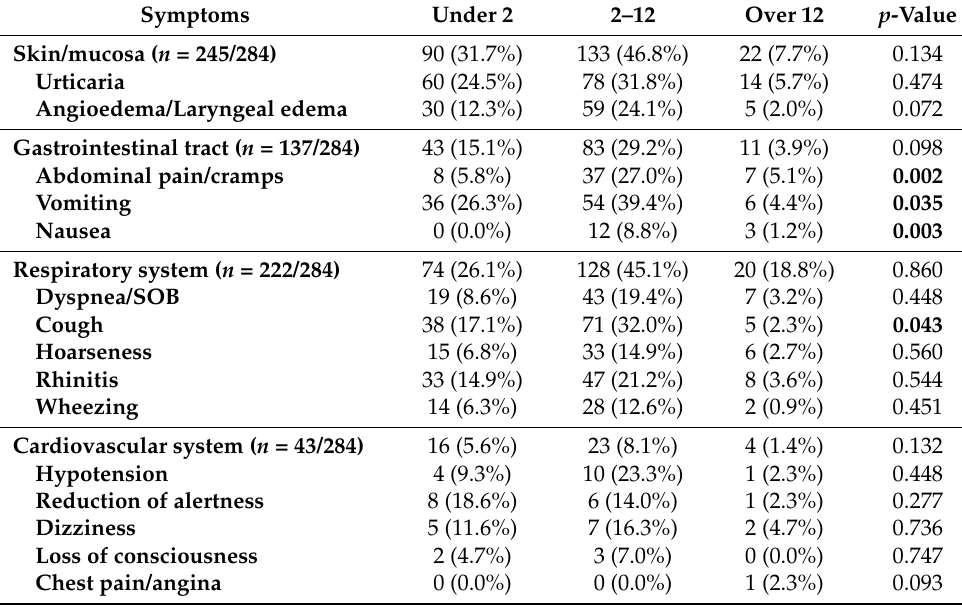
Table 1. Anaphylactic reactions’ symptoms, in regard to age.